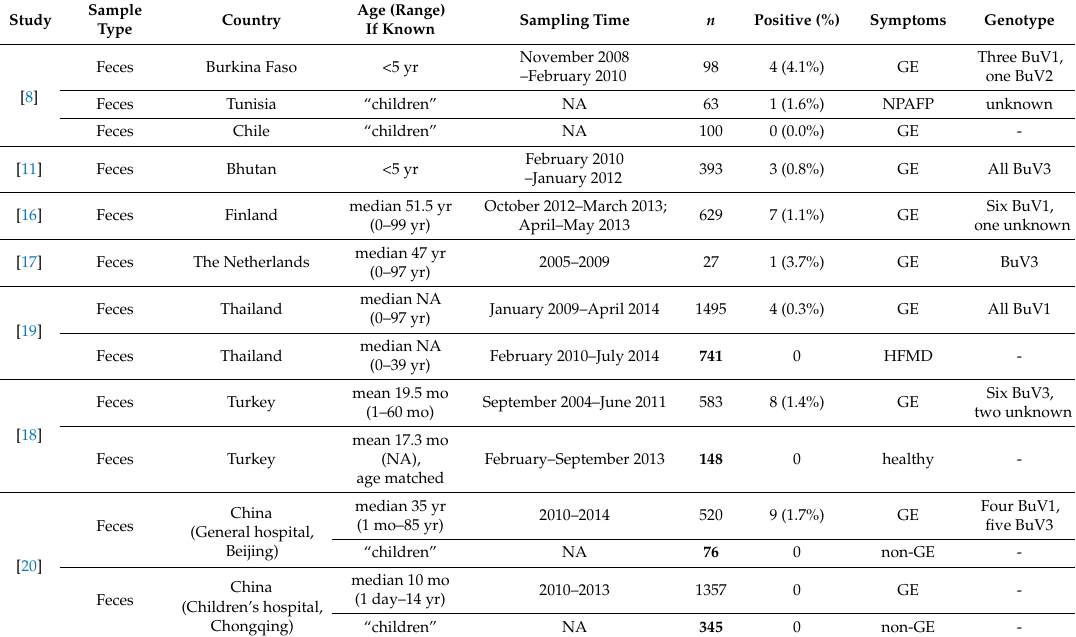
Table 1. BuV DNA studies of subjects with or without